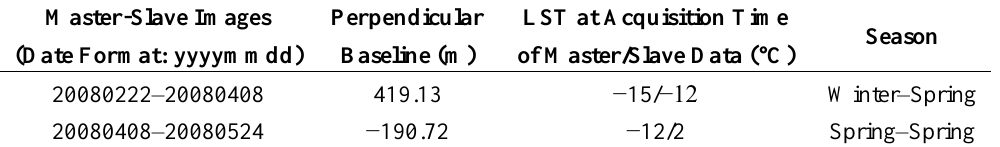
Table 1. Multitemporal of PALSAR InSAR HH data and land surface temperature (LST) derived from Moderate-resolution Imaging Spectroradiometer (MODIS) LST daily nighttime products.